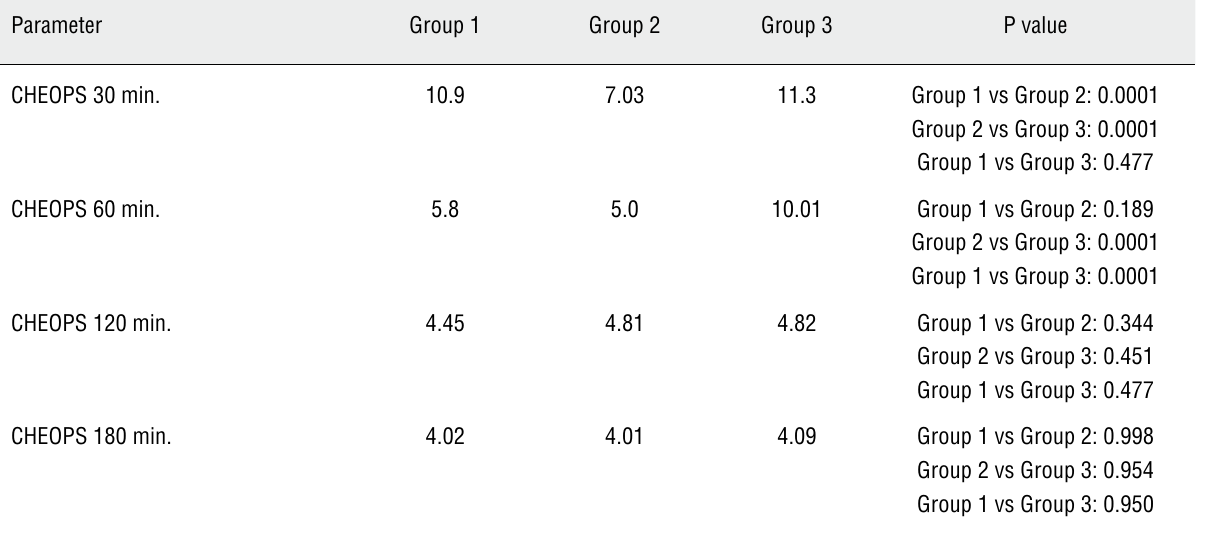
Table 2 - ChEOPS scores of the three groups at certain time intervals. Parameter Group 1 P value CHEOPS 30 min.